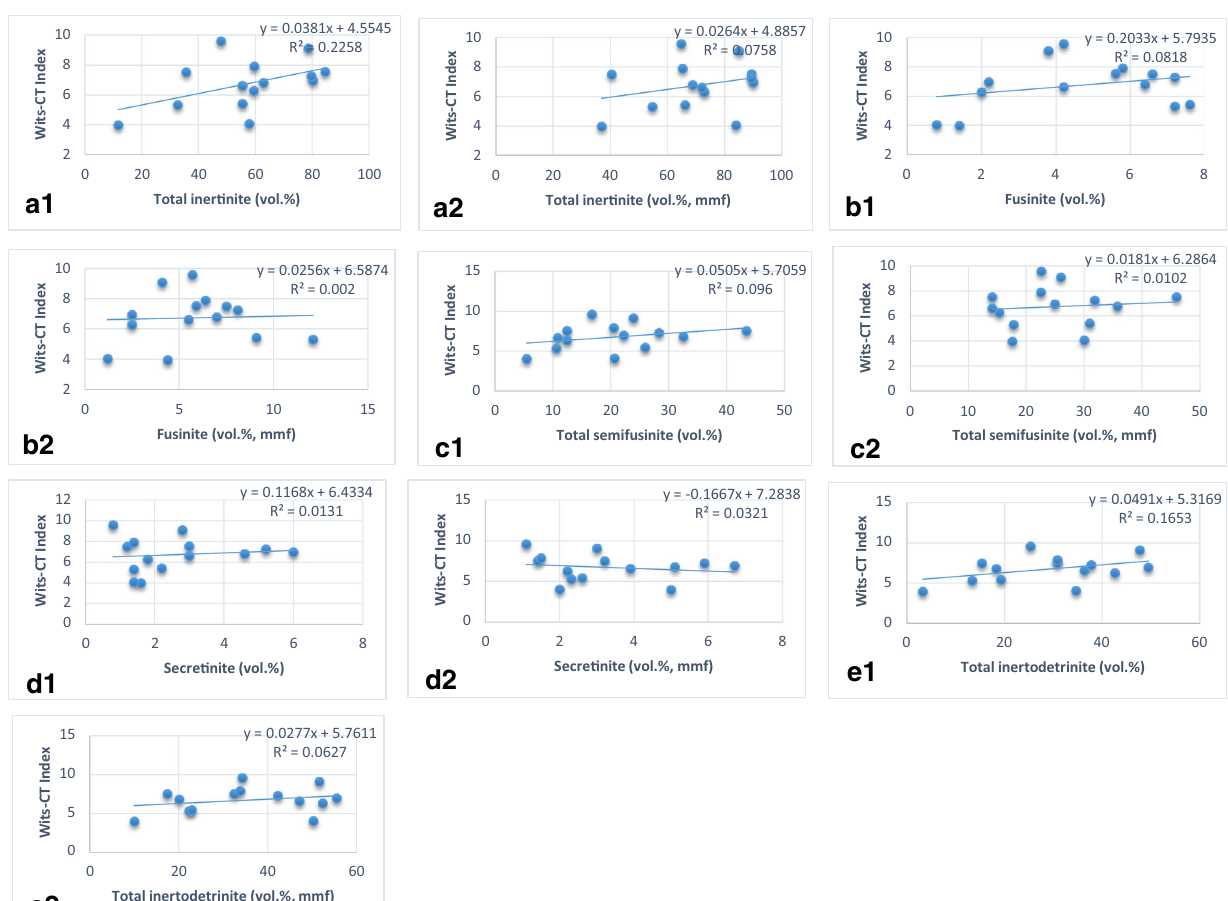
Fig. 10 Influence of inertinite and its group on spontaneous combustion of